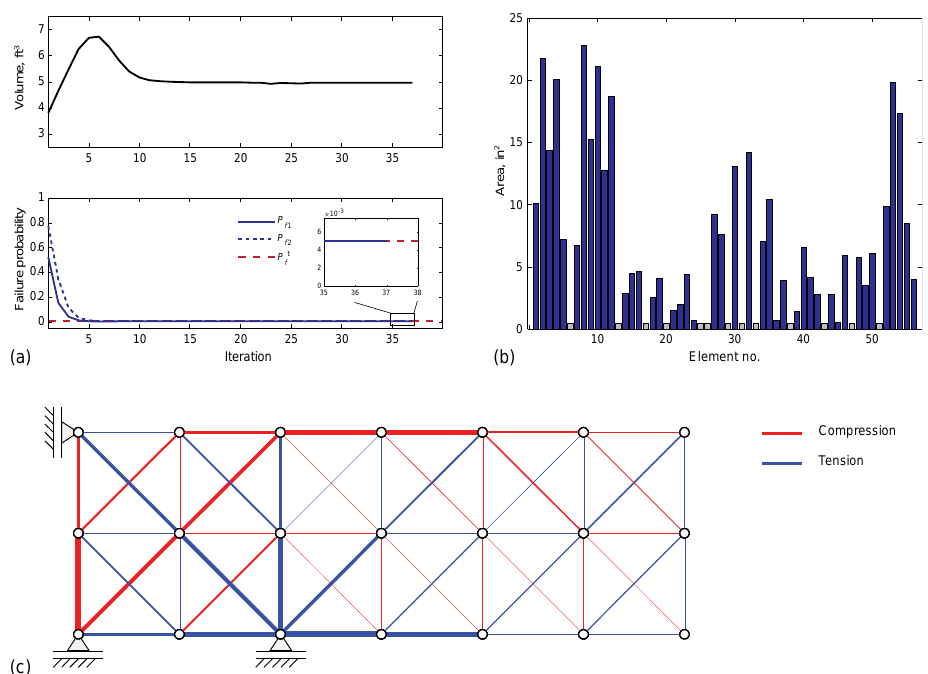
Figure 13. Results of the proposed RBDO/CS – SORM-i: ( a ) Convergence histories of volume and failure probability, ( b ) cross-sectional areas (elements having the minimum area of 0.5 in 2 are in grey), and ( c ) illustration of normalized cross-sectional areas of elements (elements in blue are in tension and those in red are in compression).